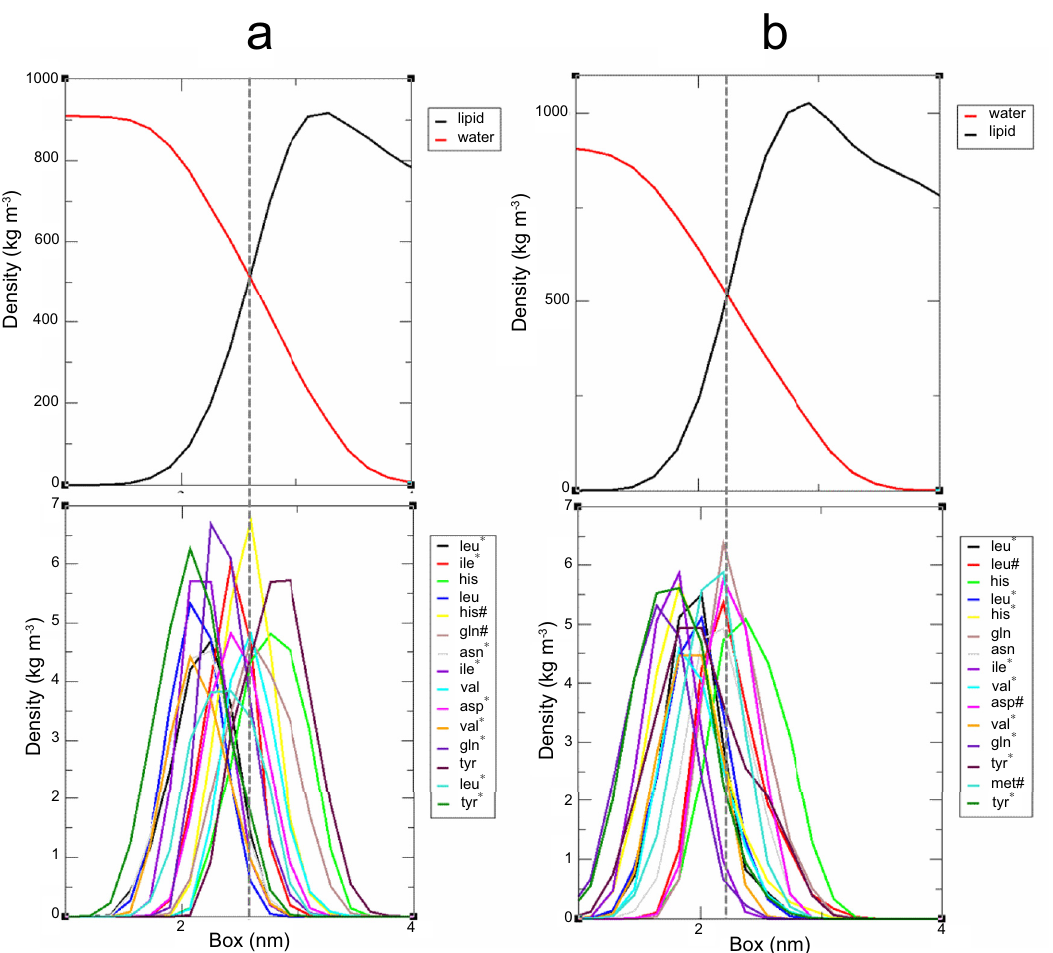
Supplementary Figure 2. Residue distribution at the lipid-water interface. ( a ) Ideal helix model. ( b ) 2KZQ NMR structure. Residues denoted with asterisk (*) and hash (#) are distributed in water (hydrophilic environment) and lipid-water interface, respectively. Residues without denotation are distributed in the lipid bilayer (hydrophobic